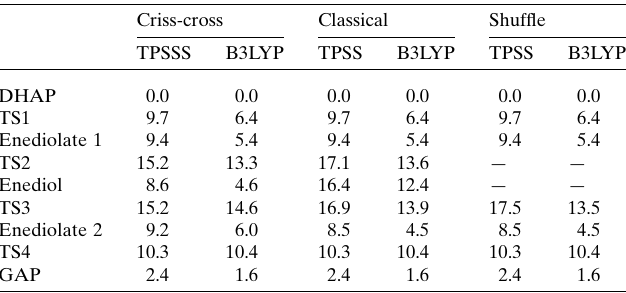
Table 3 QM/MM relative energies (in kcal mol (cid:5) 1 ) at the TPSS-D3 and B3LYP- D3 levels (both with the def2-TZVPD basis set) of the intermediates in the TIM isomerization reaction in the classical, criss-cross and shuffle